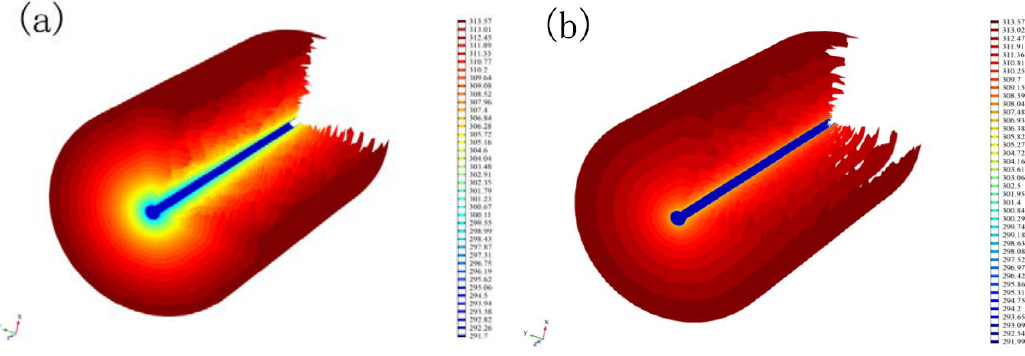
Figure 9. Comparison of thermal insulation effect of supporting materials (longitudinal section): ( a ) cloud map of the temperature field of the concrete support roadway; ( b ) cloud diagram of temperature field of test specimen XX45 insulation support roadway.